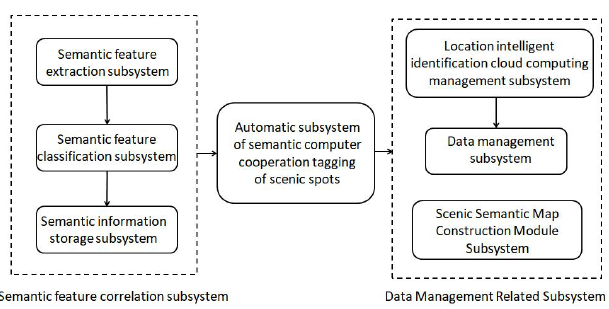
Figure 1 Scenic Spot Semantic Map Generation System